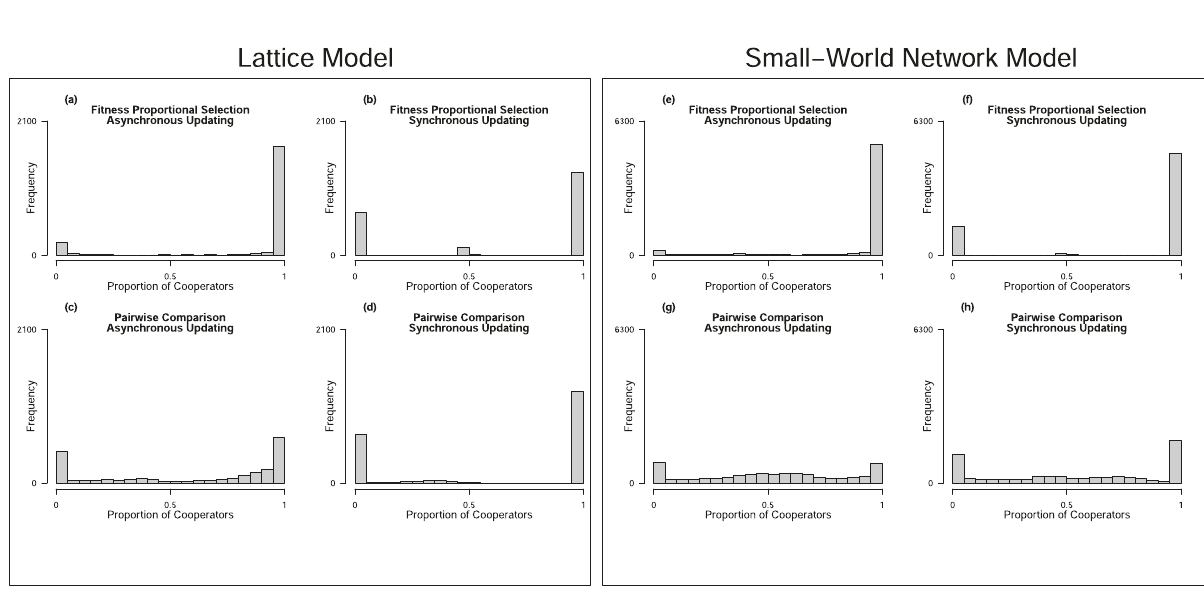
Fig. 5 Final proportion of cooperators in the population under various combinations of transition rules and update dynamics. Panels present the count of simulation runs with a given proportion of cooperators at G = 10000 under different transition rules and update dynamics. a – d Present data from models in which agents interacted on a lattice, while e – h present data from models in which agents interacted in a small-world network. The index presented in Table 1, as well as the main heading of each panel, distinguishes the combination of transition rule and update dynamics used in the simulation that generated data for a given panel. In each panel, we sort data into 5-unit bins of the horizontal axis, beginning at the minimal possible value (zero) and proceeding to the maximal possible value (unity); the gray bars then display the count of simulation runs (i.e., frequency) that ended with a proportion of cooperators resting within the range of a given bin.